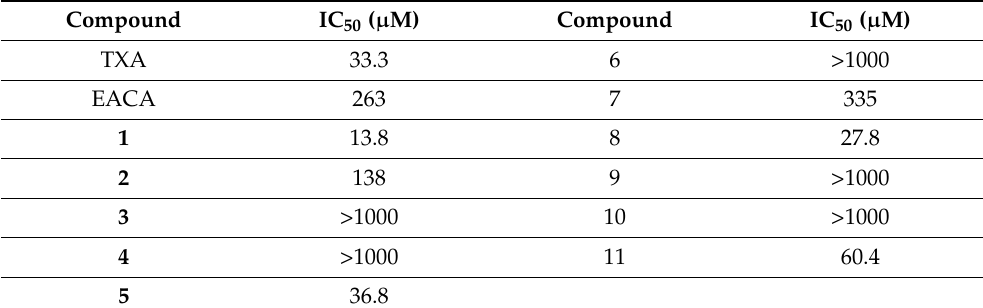
Figure 3. Dose–response curve for each molecule represented as a percentage of fibrinolysis vs. concentration ( µ M) of inhibitor measured in plasma clot lysis assays. Compounds not included in this graph showed undetectable activity below 1000 µ M. Table 1. IC 50 values for all tested compounds. IC 50 was considered as the concentration at which each inhibitor reduced the fibrinolytic activity by